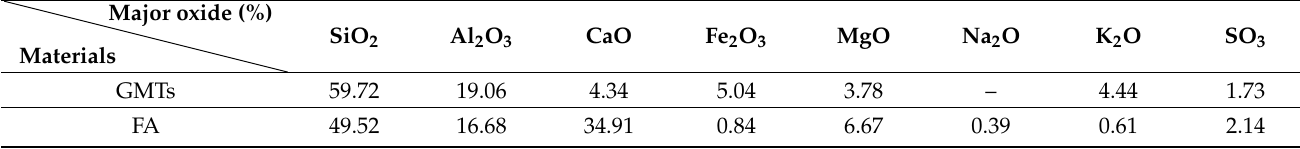
Table 4. Main chemical composition of materials